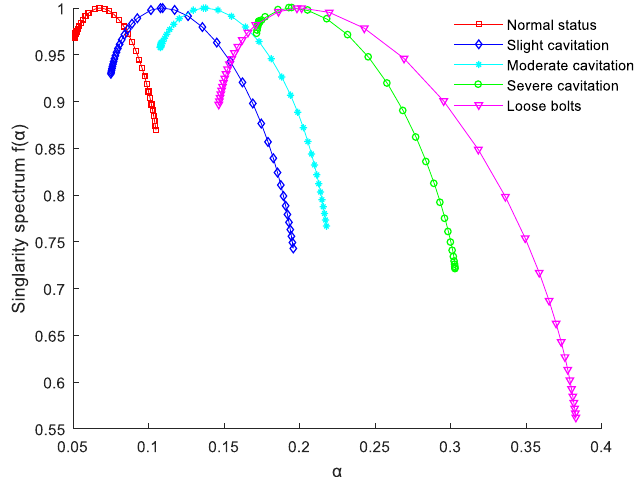
Figure 6. Multi-fractal spectrum of centrifugal pump vibration signals.